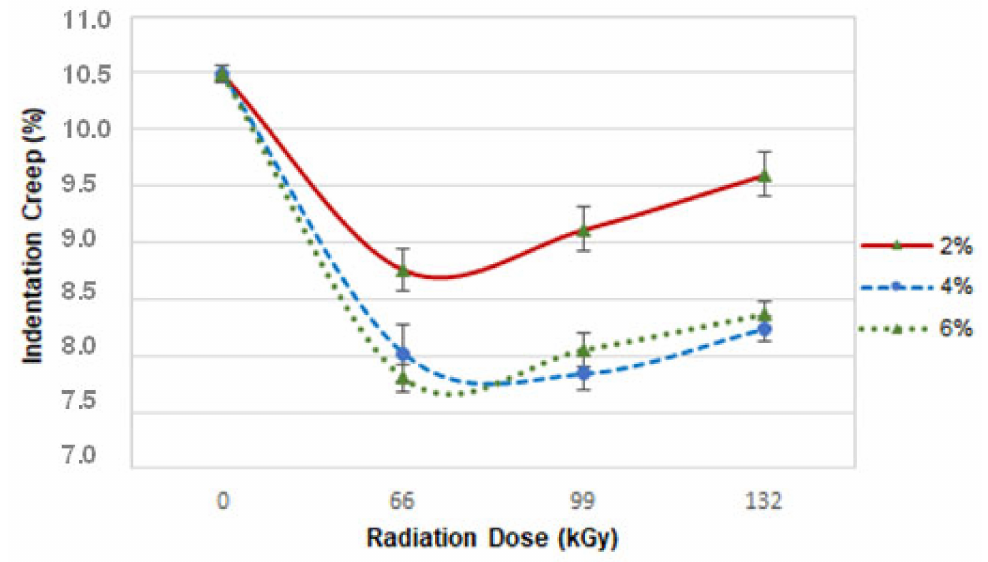
Figure 7. Dependence of indentation creep on radiation intensity and TAIC